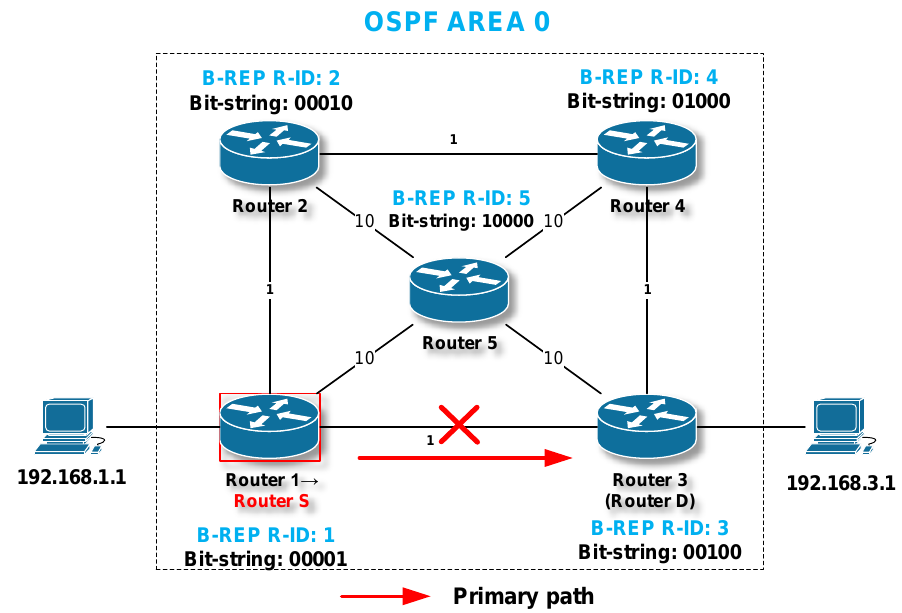
Figure 8. Detection of a failure and the reaction of the B-REP mechanism.